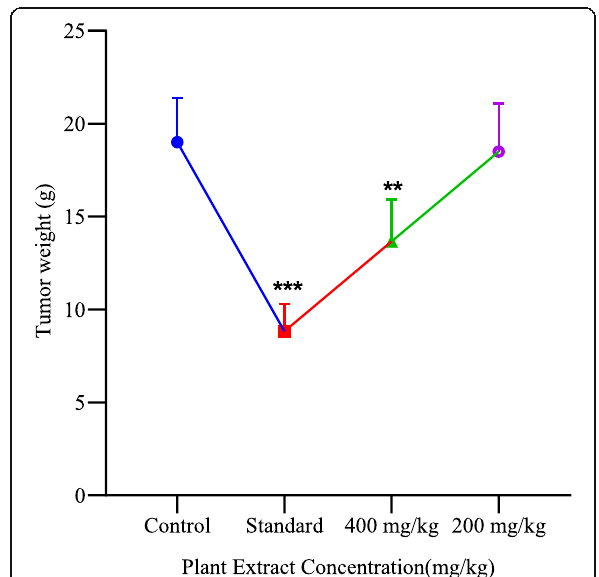
Fig. 5 Tumor weight (g) of EAC cell bearing Swiss albino mice after 15 days of treatment with Chenopodium album leaf